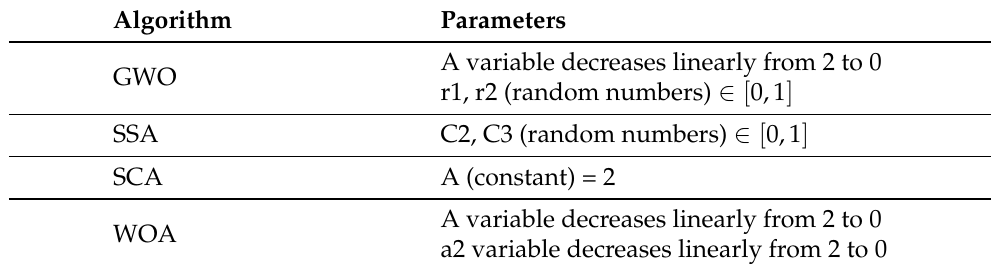
Table 1. Parameter sets of the